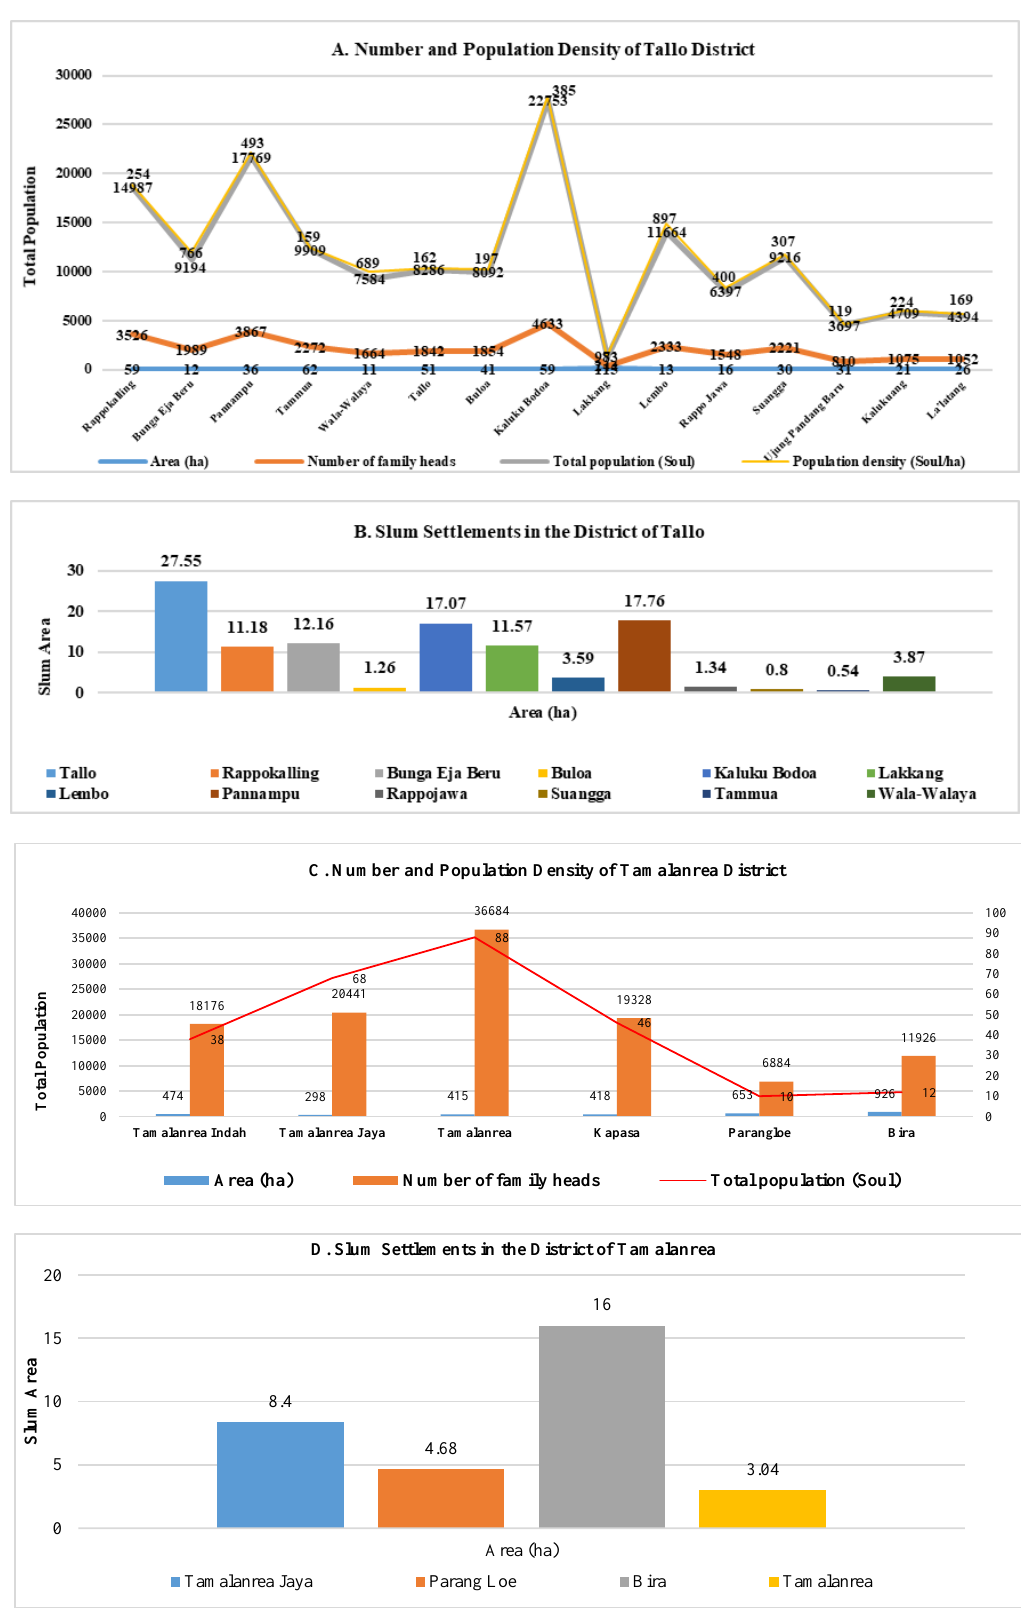
Figure 7. Number of Population and Area of Slums in Tallo District and Tamalanrea District. Source: Makassar Central Statistics Agency [33] .